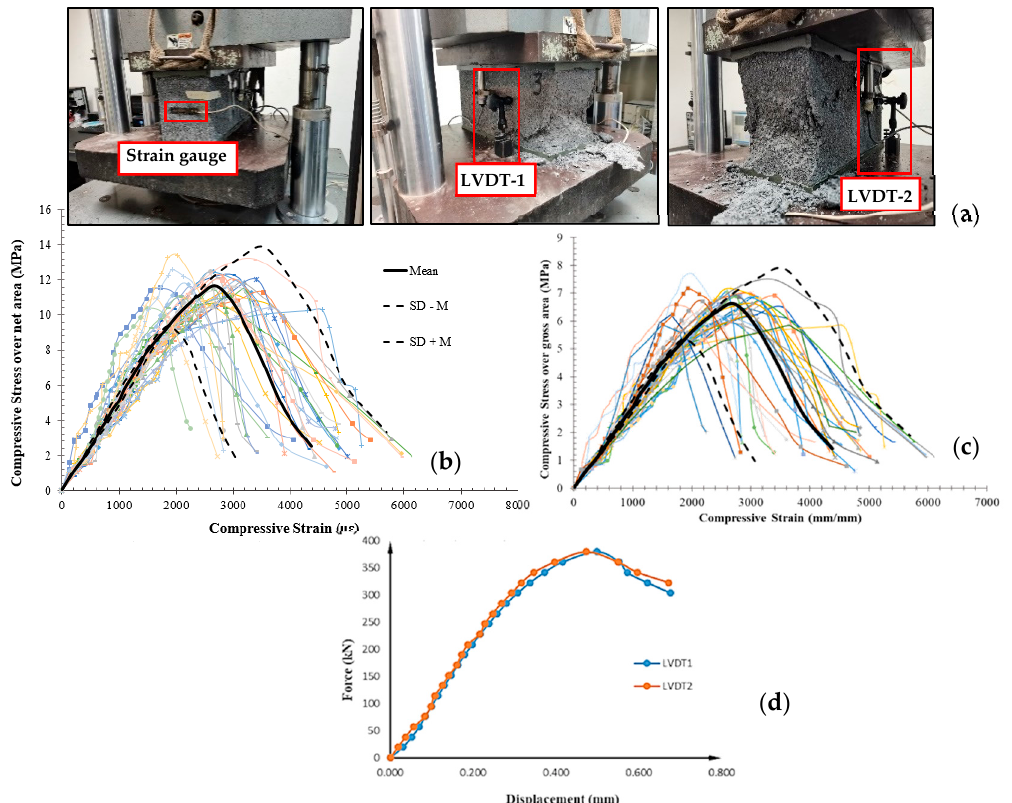
Figure 3. Results from the compressive test: ( a ) failure mode, ( b ) stress – strain curves over the net area, ( c ) stress – strain curves over the gross area, ( d ) force – displacement curves from LVDTs.